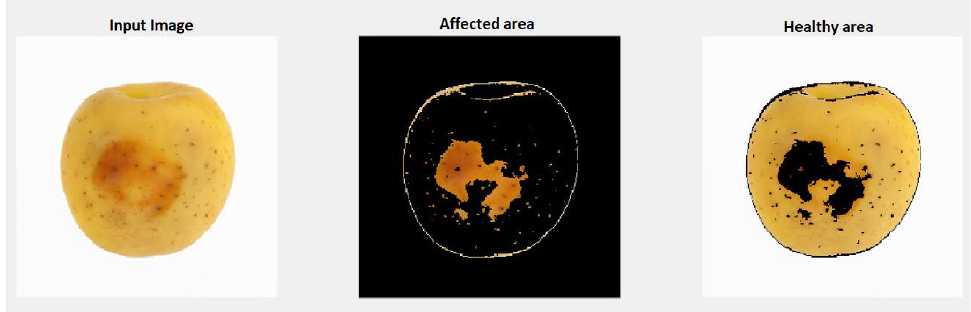
Figure 4 . Example of the input fruit, showing the separated infected and healthy parts [24].